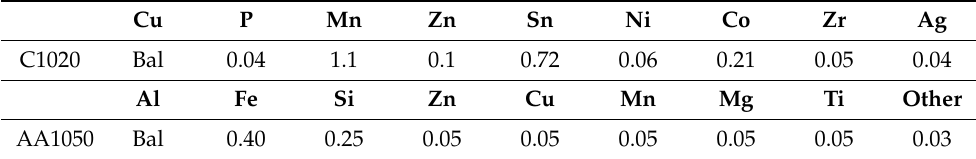
Table 1. Material chemical distribution